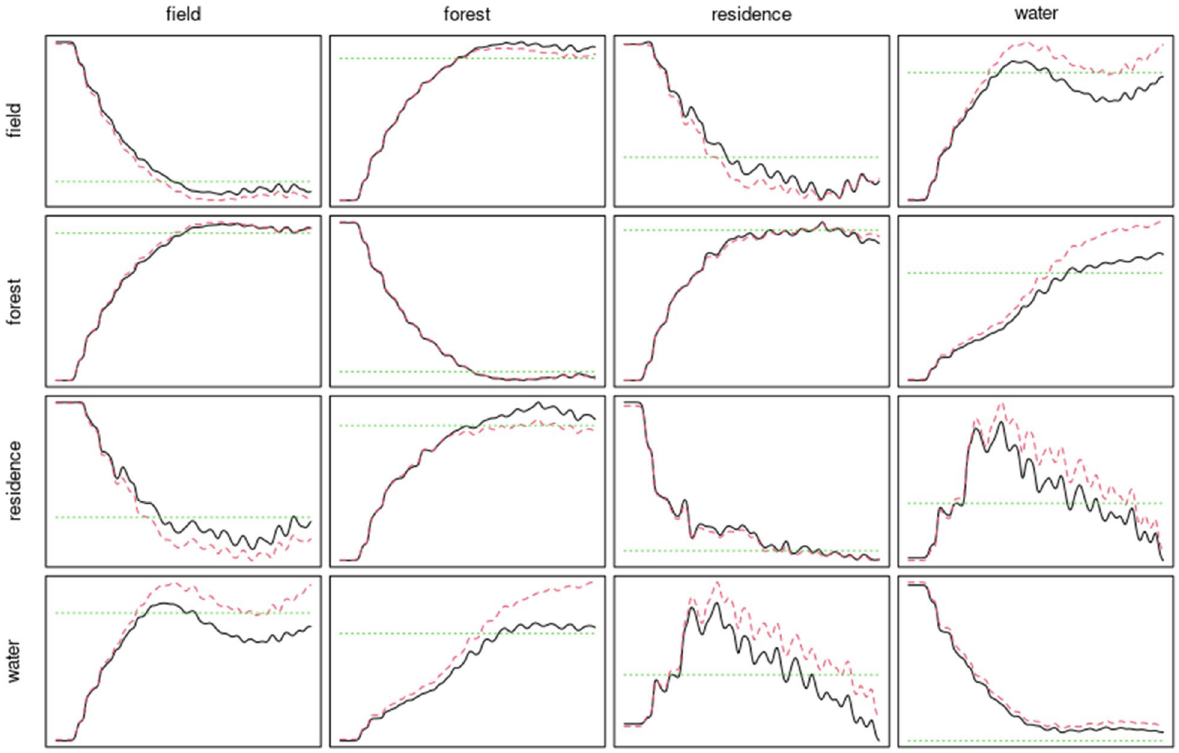
Figure 2. An array of mark connection functions for point patterns from Fig. (Fig. 3b) indicates a low (0.01) probability of finding buildings in the forest, which is as expected for restricted areas. Similarly, comparing dependency plots of water-field and water-forest pairs (Fig. 3c, d), we can conclude that water resources are mostly surrounded by forests. The last plot (Fig. 3e) indicates the probability of finding buildings near the water.